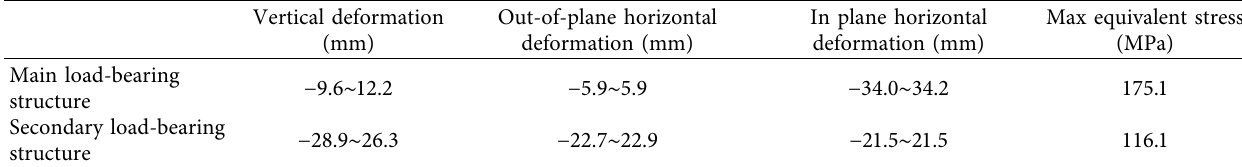
Table 8: Statistical table of overall deformation and steel structure